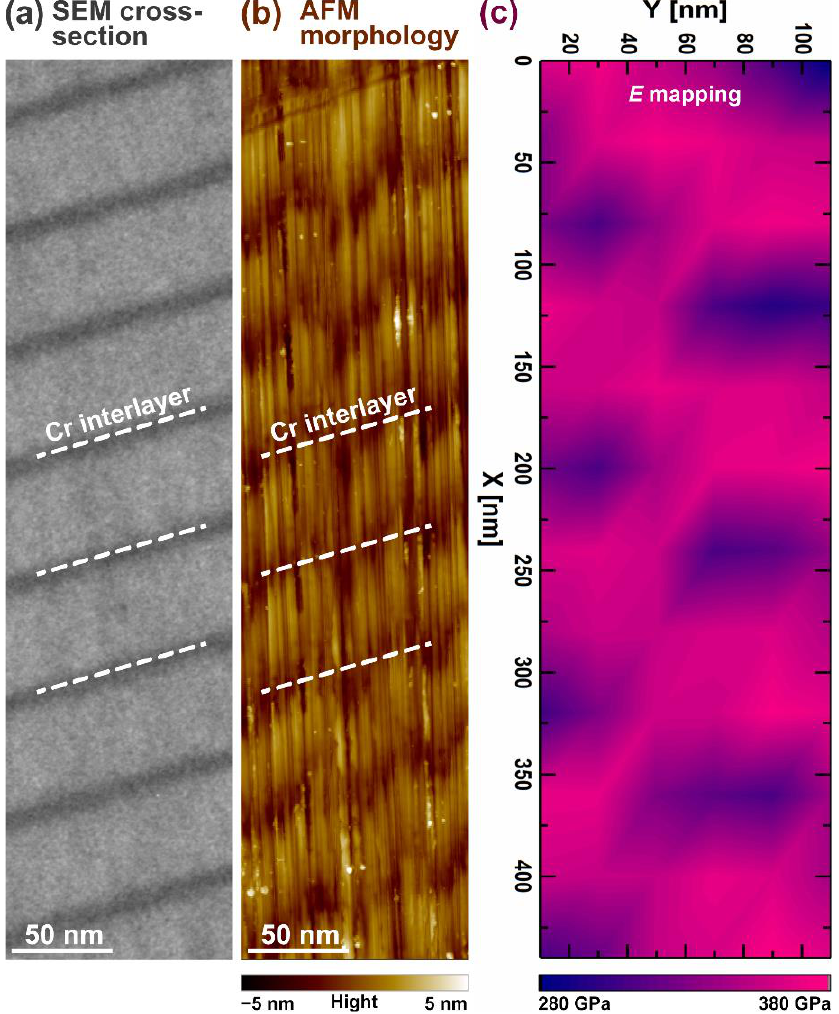
Figure 4. Elastic modulus characterization of the TiB 2 /Cr multilayer film using AFM. ( a ) Cross-section morphology of the film. ( b ) Height of the film cross-section. ( c ) Elastic modulus E mapping of the film cross-section.